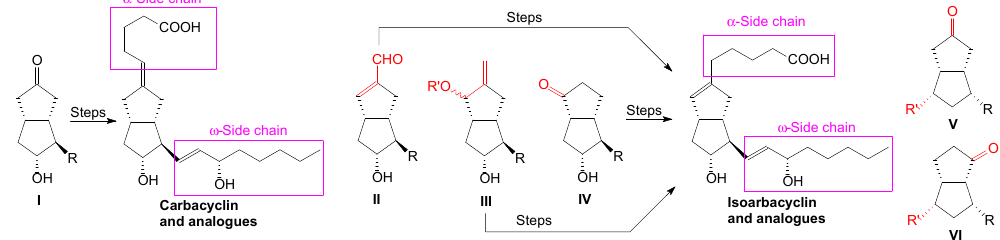
Figure 1. Key intermediates for synthesis of carbacyclin and isocarbacyclin analogues.